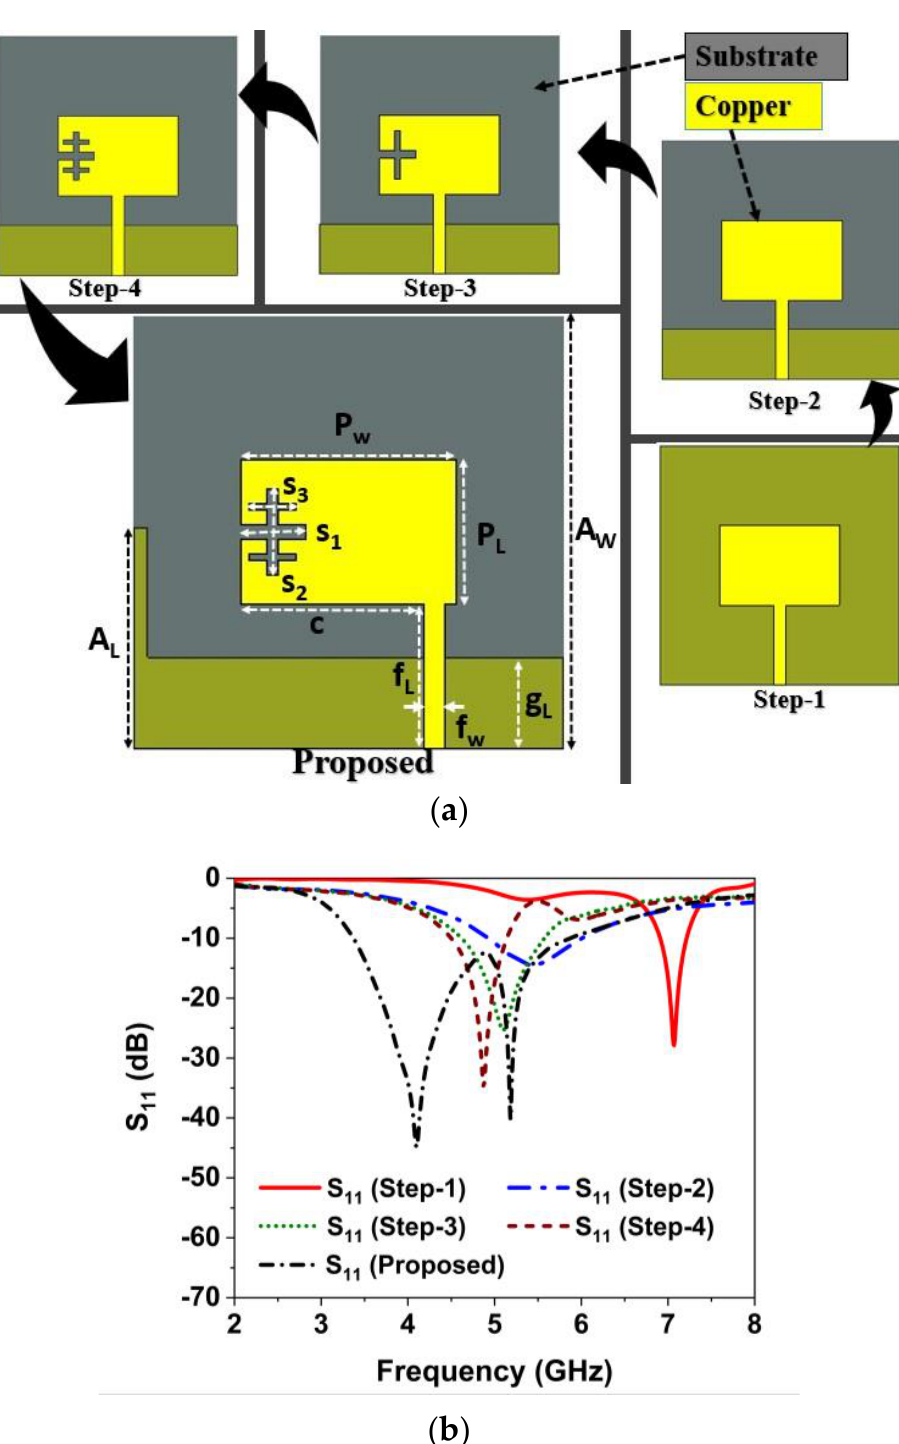
Figure 3. ( a ) Initial antenna design steps ( b ) reflection coefficient (S 11 ) results.